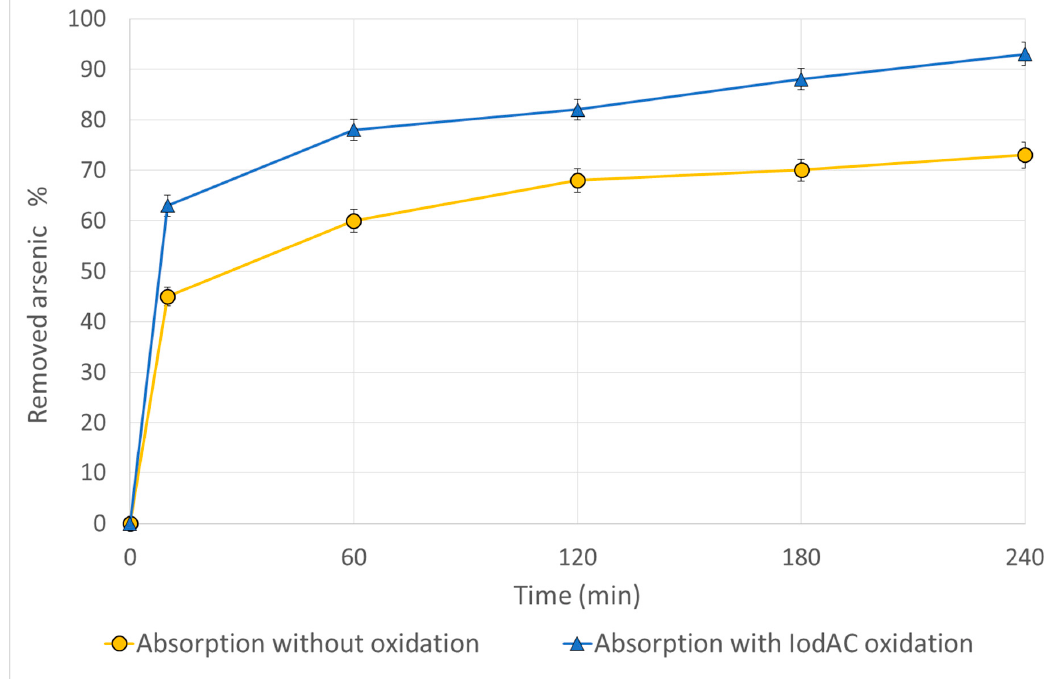
Figure 5. Comparison of the kinetic of arsenic adsorption on iron-impregnated activated carbon, with or without the use of IodAC.